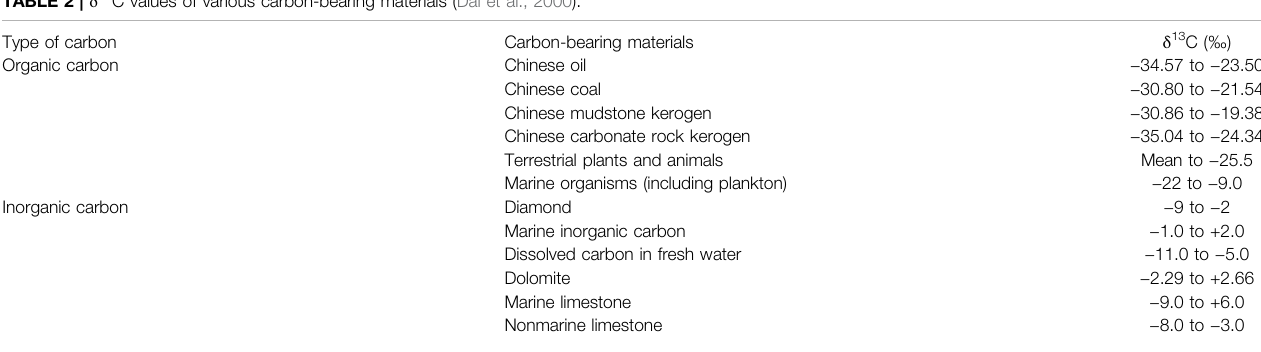
TABLE 2 | δ 13 C values of various carbon-bearing materials (Dai et al.,